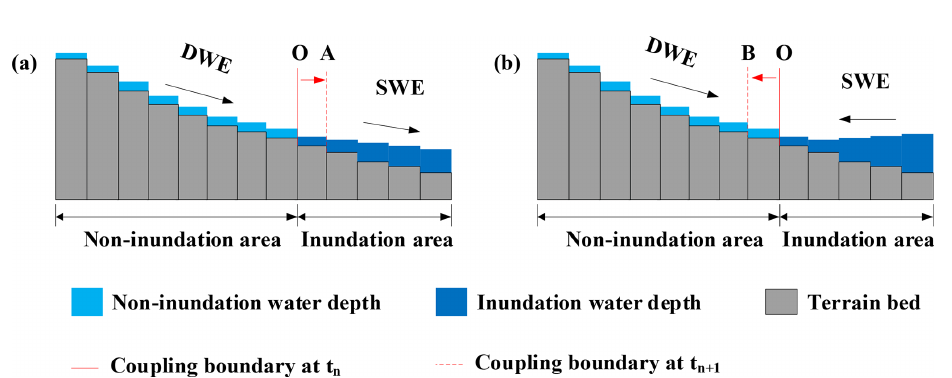
Figure 2. Schematic diagram of DBCM.